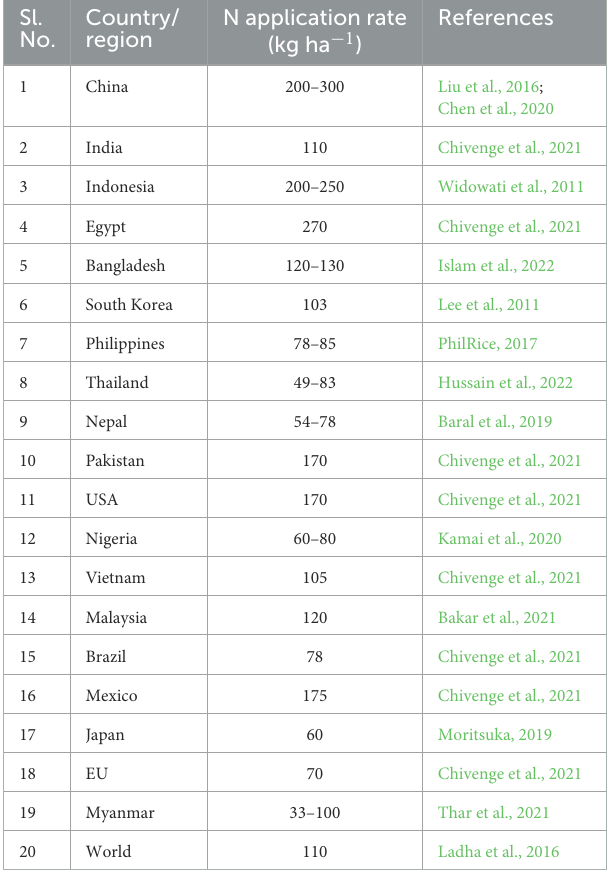
TABLE 1 Nitrogen application rate for rice cultivation throughout the world. Sl.